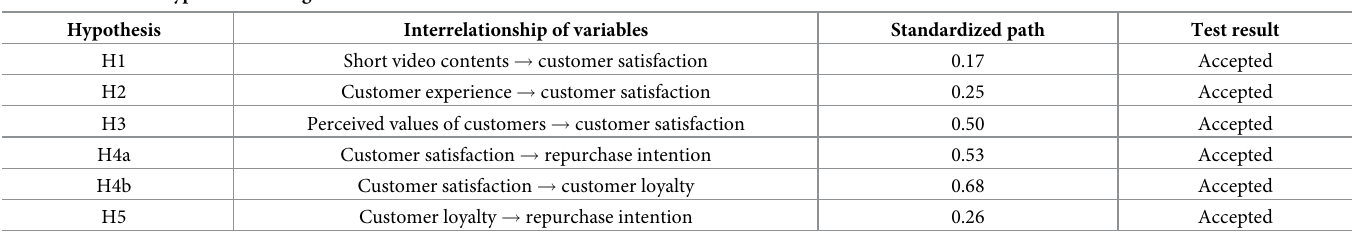
Table 7. Results of hypothesis testing.